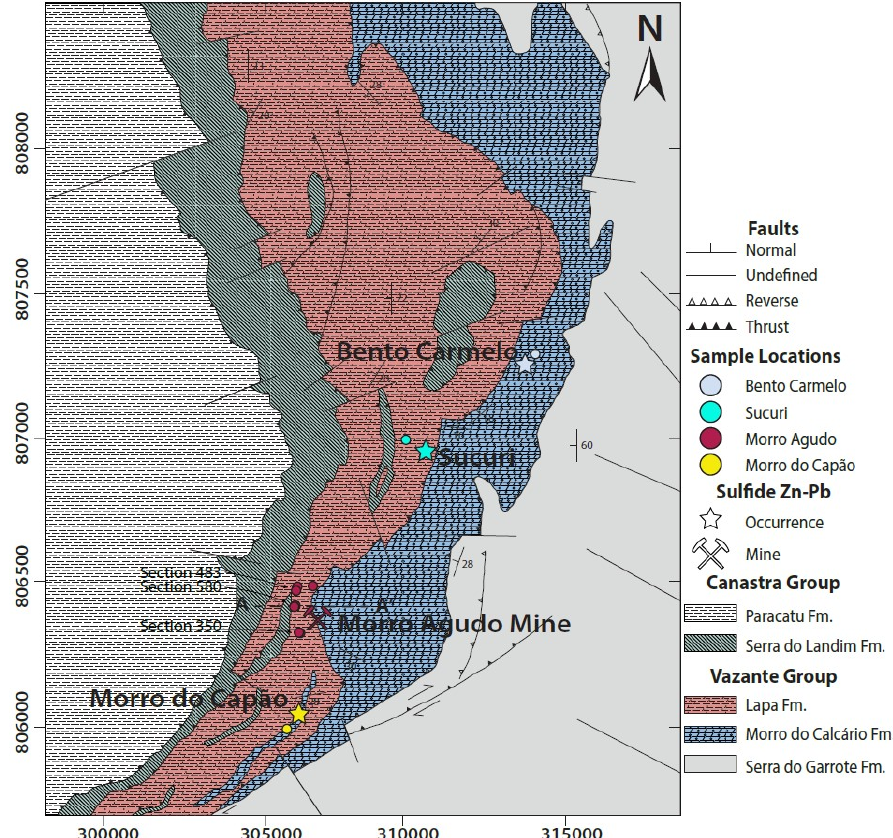
Figure 3. Local geology of the Morro Agudo district displaying the locations of the Zn-Pb deposit and occurrences and the locations of selected samples for this study (modified from [15,20] and internal Nexa database).